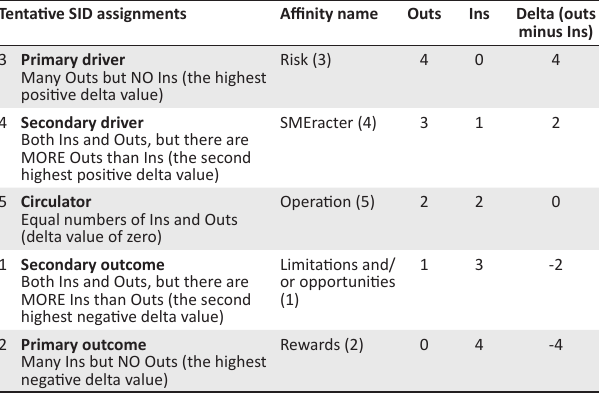
TABLE 4: Determining the drivers and outcomes for the system influence diagram. Tentative SID